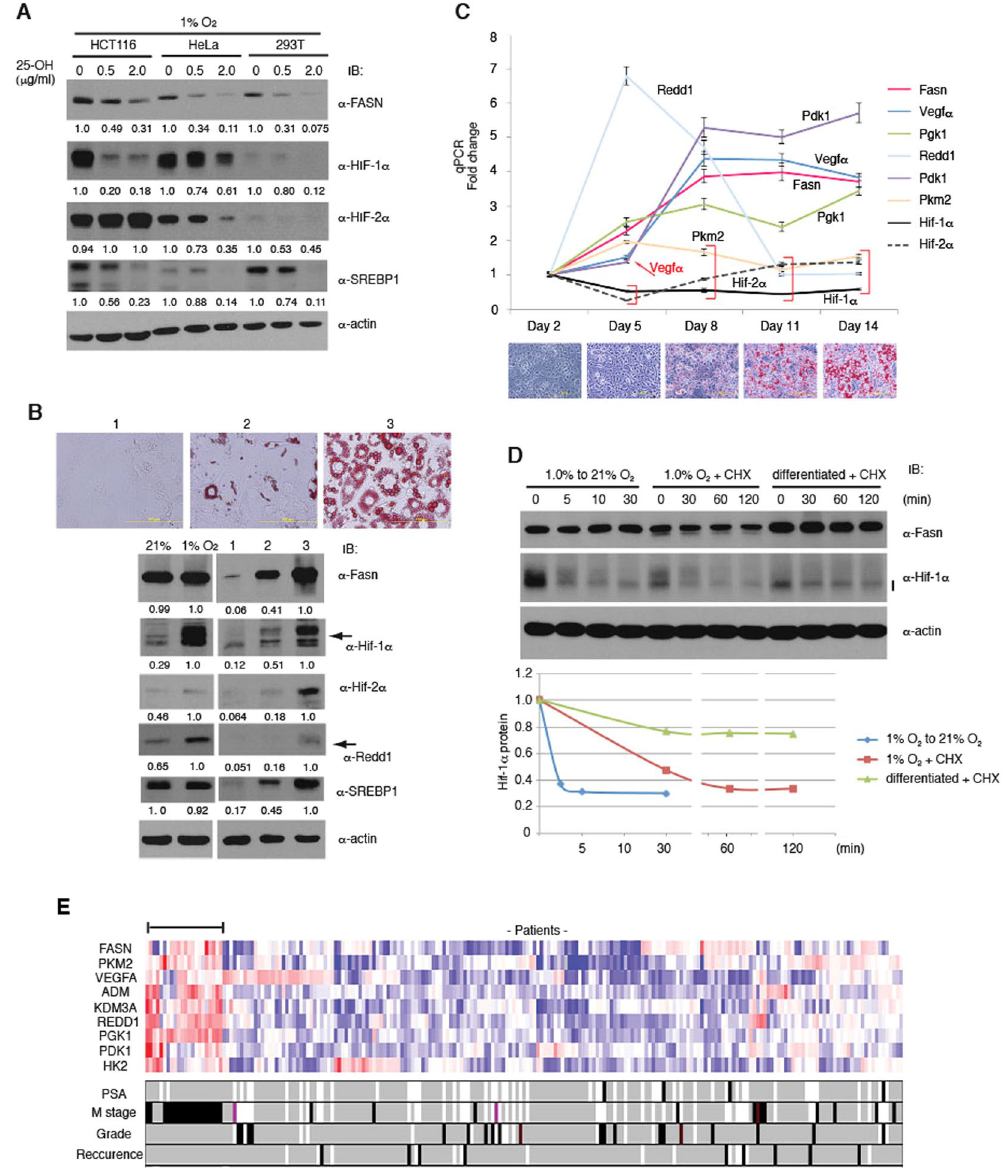
Figure 4. Correlation between HIF- α , FASN Protein Levels and HIF Target Gene Expression in Adipogenesis and Prostate Cancer. ( A ) Downregulation of HIF- α protein levels by 25-OH treatment. HCT116, HeLa and 293 T cells were treated with 25-OH for 72 h and incubated for the last 4 h in 1% oxygen. HIF- α levels were analyzed by western blotting. ( B ) Hif- α activation during differentiation of 3T3-L1 cells into adipocytes. Confluent 3T3-L1 cells were cultured for 14 days in regular medium (1), or differentiation medium in the presence of insulin alone (2) or with insulin, dexamethasone, and 3-isobutyl-1-methylxanthine (3). Fasn, Hif- α and Redd1 expression was analyzed by western blotting. Lipid accumulation was monitored by staining with Oil-Red O. ( C ) Time-dependent changes of Hif target gene expression during 3T3-L1 differentiation. Inducers of differentiation were added at Day 2. mRNAs of the Hif target genes were measured by qPCR in biological triplicates and technical duplicates as a total of 6 samples and normalized against the reference gene Tbp and Day 2 samples. Data plots with p-value larger than 0.01 were indicated by red brackets and a red arrow additionally showing Vegf α at Day 2. Lipid staining results with Oil-Red O are shown under the graph for each time point. ( D ) Stability of Hif-1 α protein. Stability was measured after oxygen concentration shift (1.0% to 21% oxygen) for undifferentiated cells, cycloheximide (CHX) addition for undifferentiated cells in hypoxia, or cycloheximide addition for differentiated cells in normoxia. ( E ) Gene expression profiles of prostate cancer patients obtained from IST Online (MediSapiens) was analyzed, and mRNA levels of several HIF target genes were examined in correlation with FASN levels. Patient samples co-overexpressed with FASN are indicated with a horizontal bar. M stage: metastasis, PSA: prostate-specific antigen. Experiments were repeated twice ( A , B , D ), and the results were reproduced. The qPCR experiment ( C ) was performed once with biological